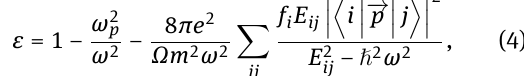
Figure 4: Comparison between reflection (top) and transmission (bottom) for 2.5 nm (a and c) and 7 nm (b and d) gold films for which the refractive index n and k are from the Drude model, nonlocal model, quantum size model, and quantum electrostatic model . The corresponding experimental results are marked by red triangles.